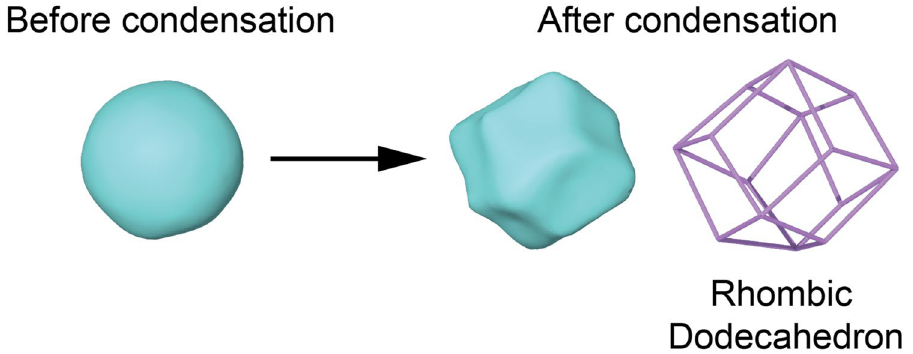
Figure 2. Shape change of spherical nanoparticles in the FCC-NG model during cold compression. After consolidation, the spherical-like nanoparticles adopt a rhombic dodecahedron polyhedron shape. Images created with OVITO version 3.5.3, https:// www. ovito.